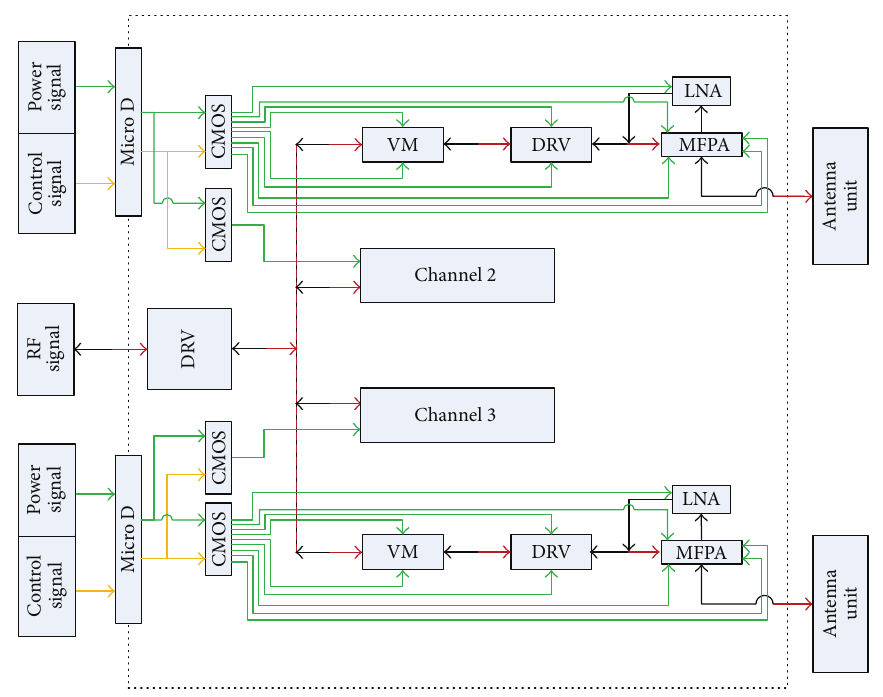
Figure 1: Schematic diagram of the designed TR module hosting the proposed